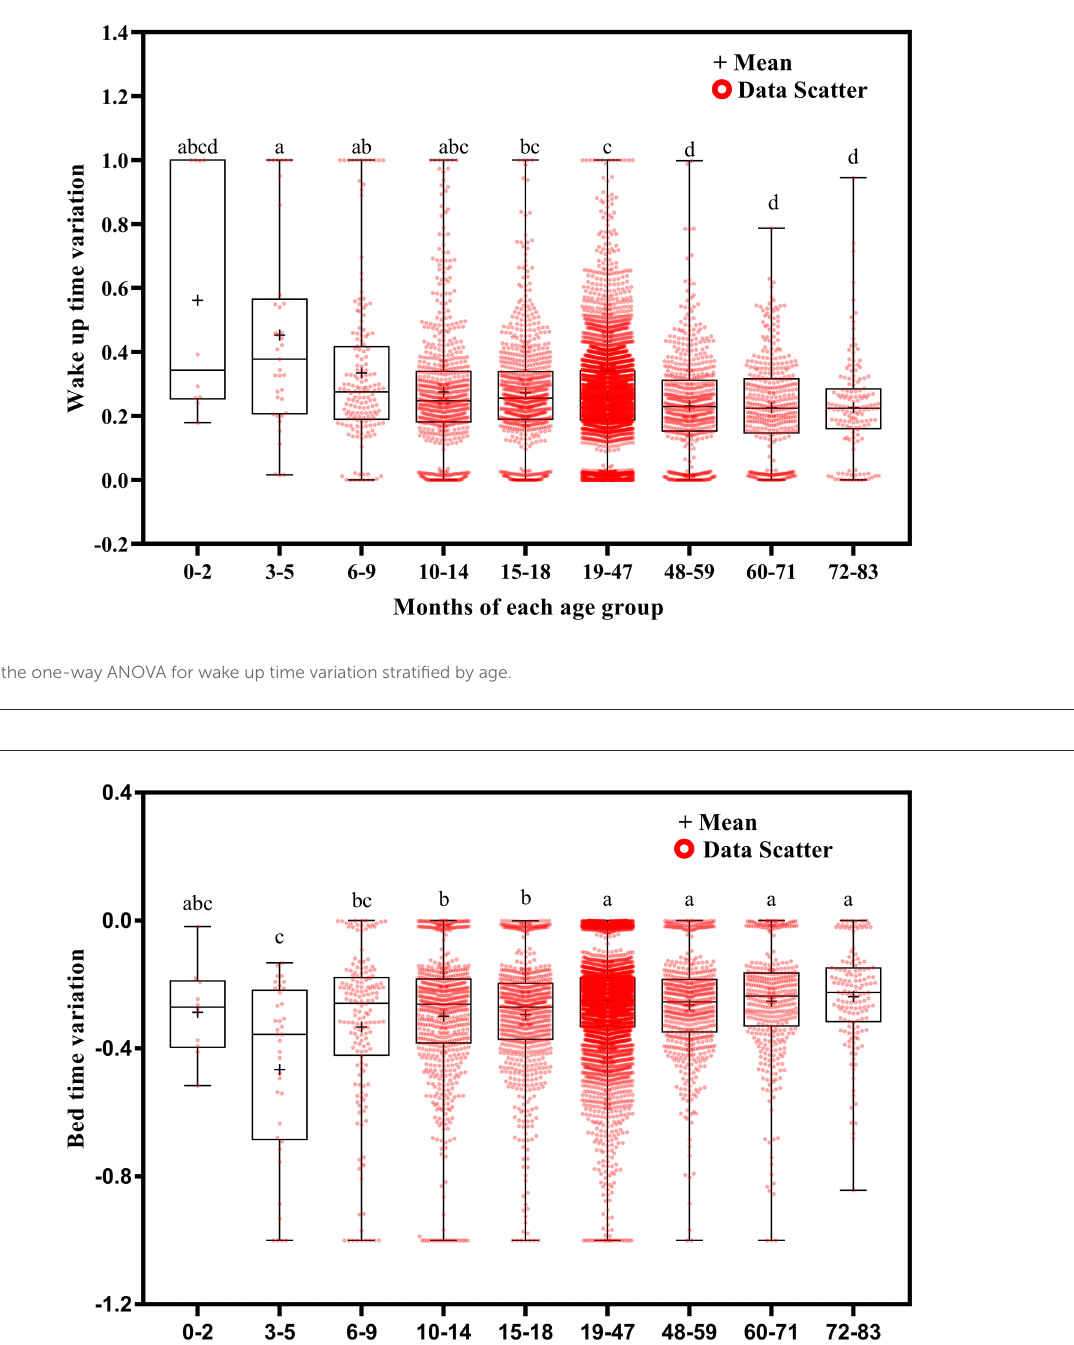
months ( p = 0.029) and in children aged 15–18 months than in those aged 19–47 ( p < 0.001), 48–59 ( p = 0.005), 60–71 ( p < 0.001), and 72–83 ( p < 0.001) months. The